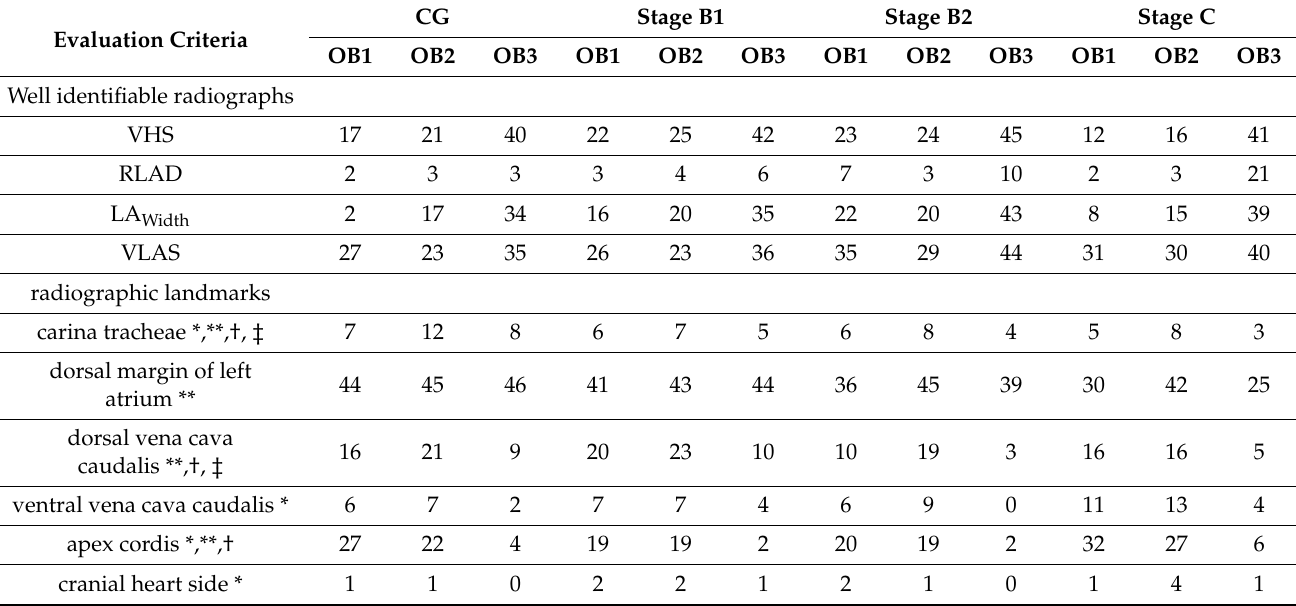
Table 6. Distribution of conventional well identifiable radiographs and radiographs with measure- ment difficulties measured by the individual observers.